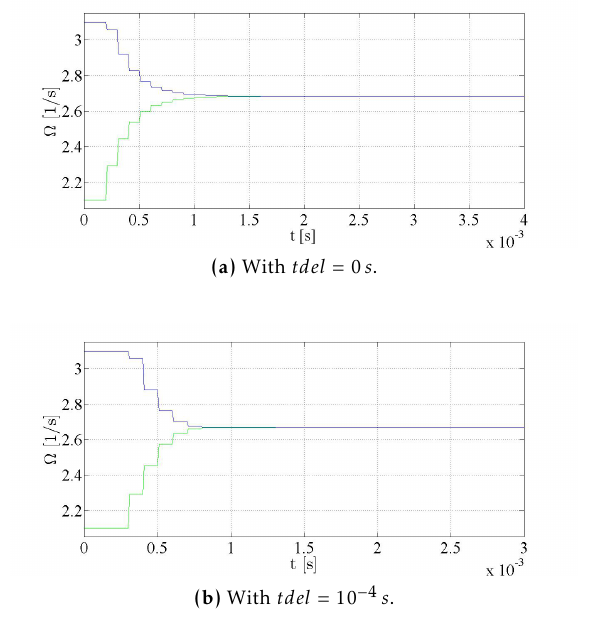
Figure 9. Clock skew convergence behaviors of the two nodes.